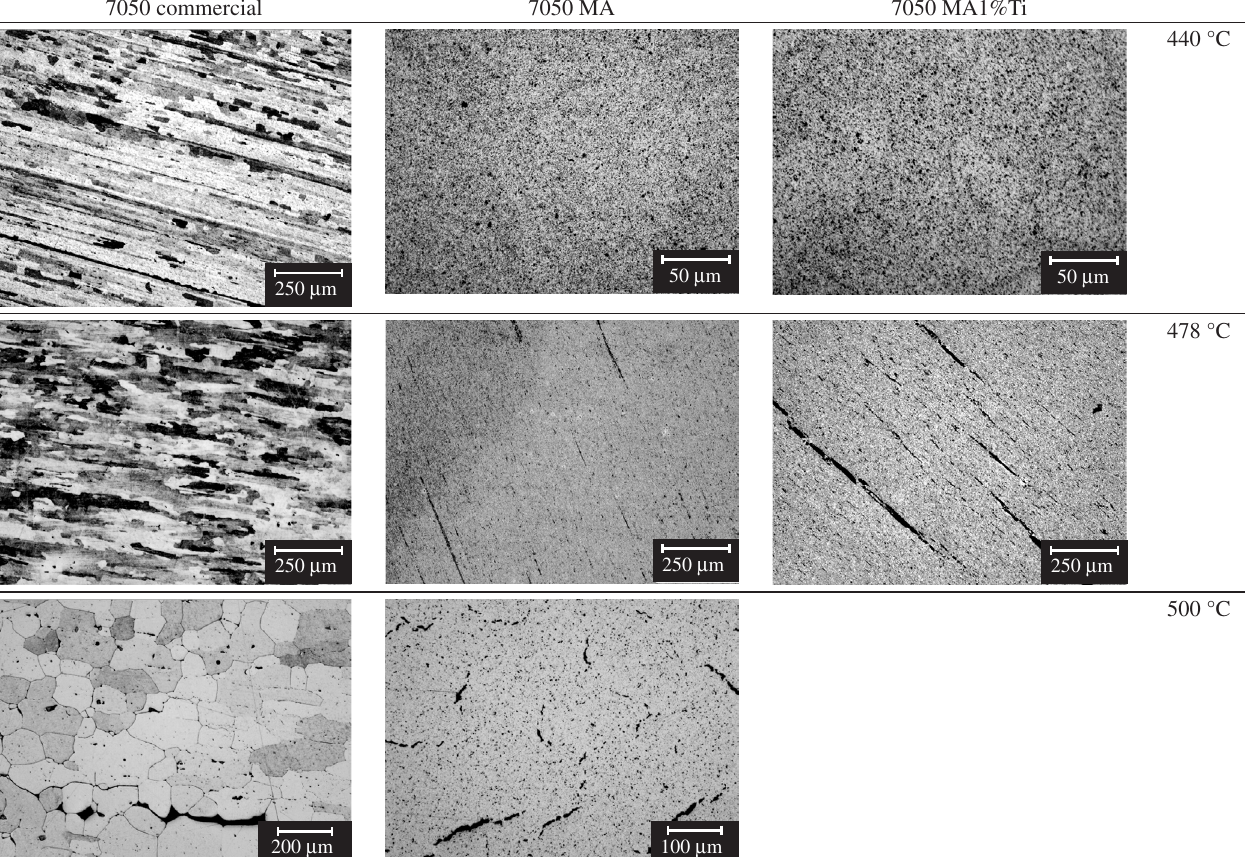
Table 3. Optical micrographs of the 7050 commercial, 7050 MA and 7050 MA1%Ti alloys after solution heat treatments at 440, 478 and 500 °C. 7050